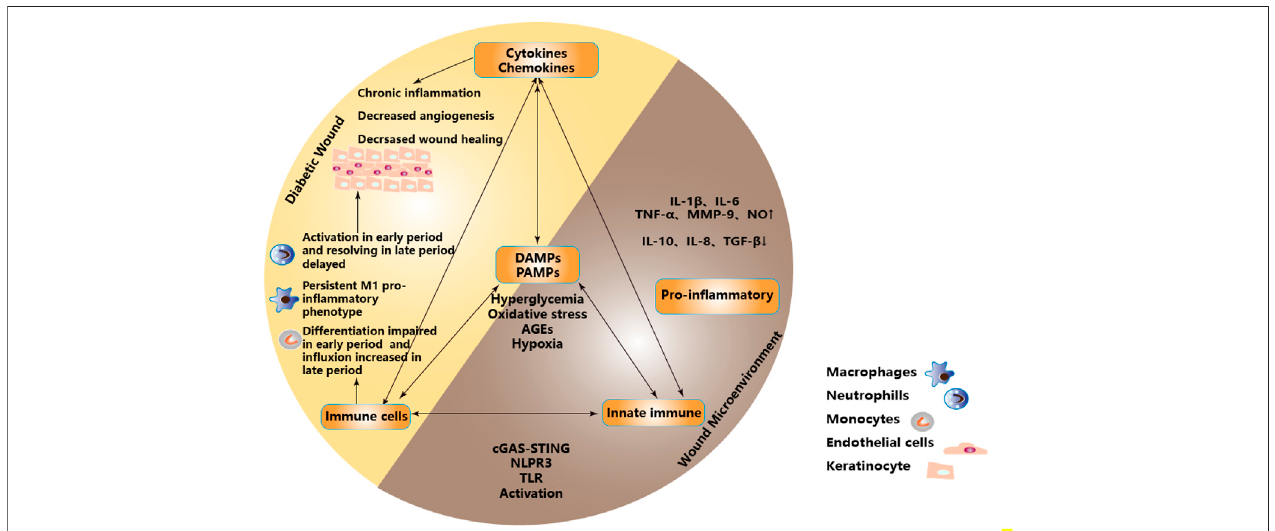
FIGURE 2 | Proin fl ammatory microenvironment in DW due to dysregulation of immune and metabolic responses. Metabolic stress such as hyperglycemia, oxidative stress, AGEs, and hypoxia acted as the initiators of PAMPs and DAMPs to activate PRRs. Inducing in fi ltration of innate immune cells and activation of innate immune pathways, regulating the balance between innate immunity and in fl ammatory microenvironment, forming a pro-in fl ammatory microenvironment, and participating in DW healing. Partial abbreviation: IL-1 β : Interleukin-1 β , IL-6: Interleukin-6, TNF- α : Tumor necrosis factor- α , MMP-9: Matrix metalloprotein-9, NO: Nitric oxide, IL-10: Interleukin-10, IL-8: Interleukin-8, TGF- β : Transforming growth factor- β , DAMPs: Damage-associated molecular patterns, PAMPs: Pathogen- associated molecular patterns, TLR: Toll-like receptor.